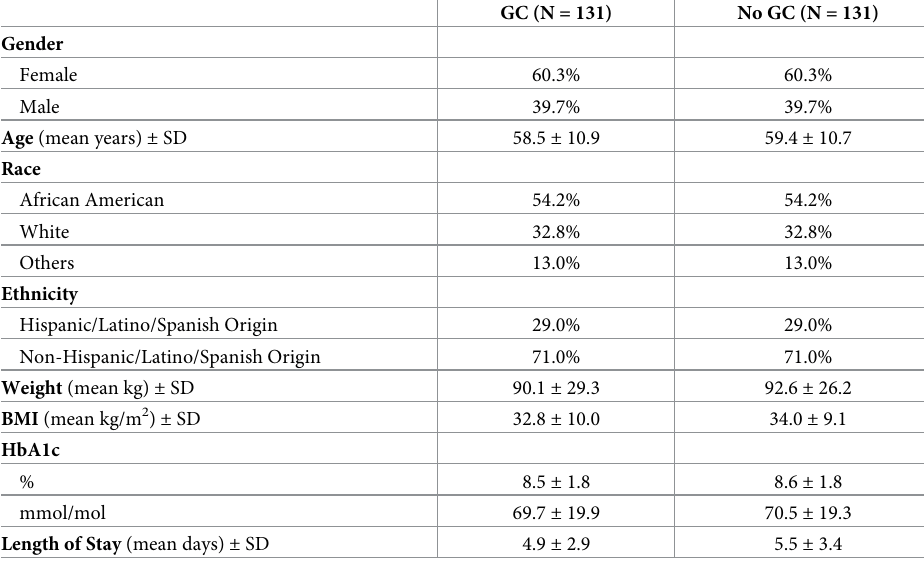
Table 1. Demographic and clinical characteristics after matching for race, gender, age, and